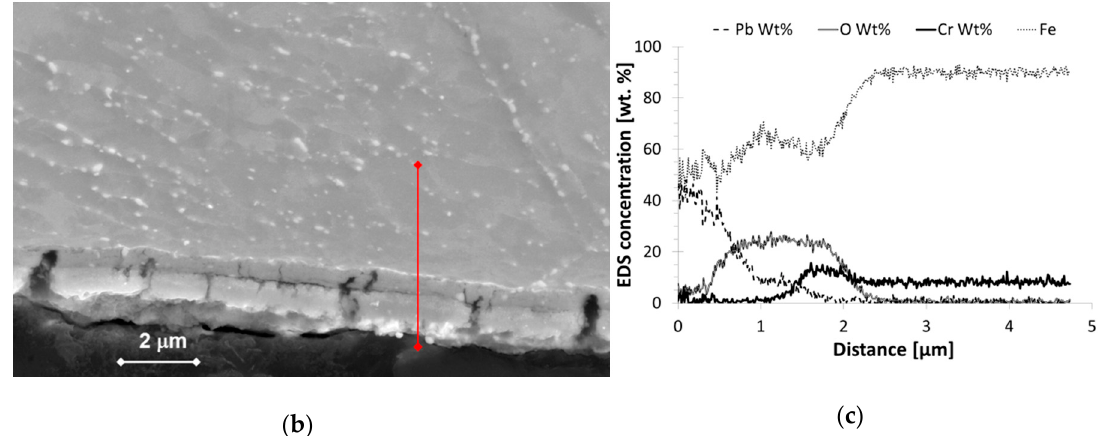
Figure 10. Tapered specimen T36 (R0) after testing in liquid Pb (without chemical cleaning): ( a ) Cross section showing the cracks limited to the oxide (secondary electron (SE)); ( b ) Cracking in the oxide scale going across and between the inner and the outer layers (back-scattering electron (BSE)); ( c ) EDS line scan across the oxide scale.